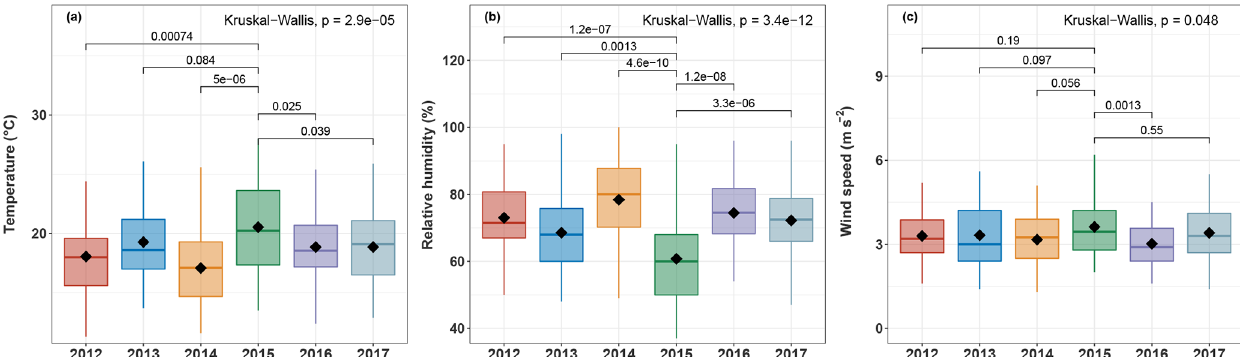
Figure 7. Boxplots of (a) maximum ambient temperature, (b) relative humidity, and (c) wind speed at OPE-ANDRA from 2012 to 2017. Analyses are performed for warmer periods (June–November). Only statistically different meteorological factors are presented. The black marker inside each boxplot indicates the average value, while the top, middle, and bottom of the box represent the 75th, median, and 25th percentiles, respectively. The whiskers at the top and bottom of the box extend from the 95th to the 5th percentiles. Statistical differences between average values were assessed with the Kruskall–Wallis method ( p < 0 .